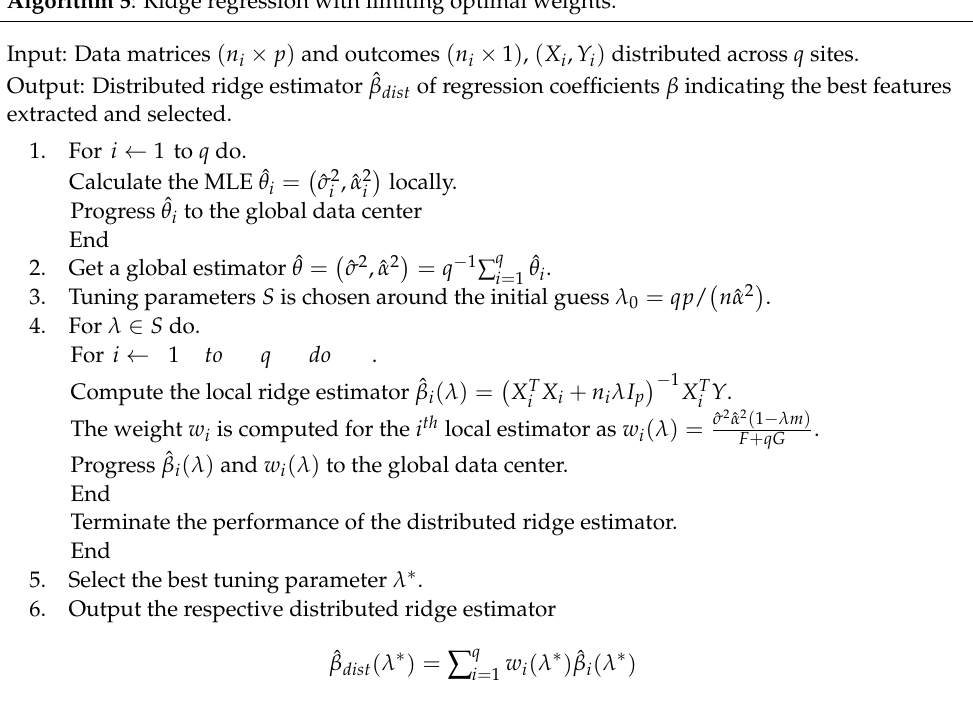
Algorithm 5 : Ridge regression with limiting optimal